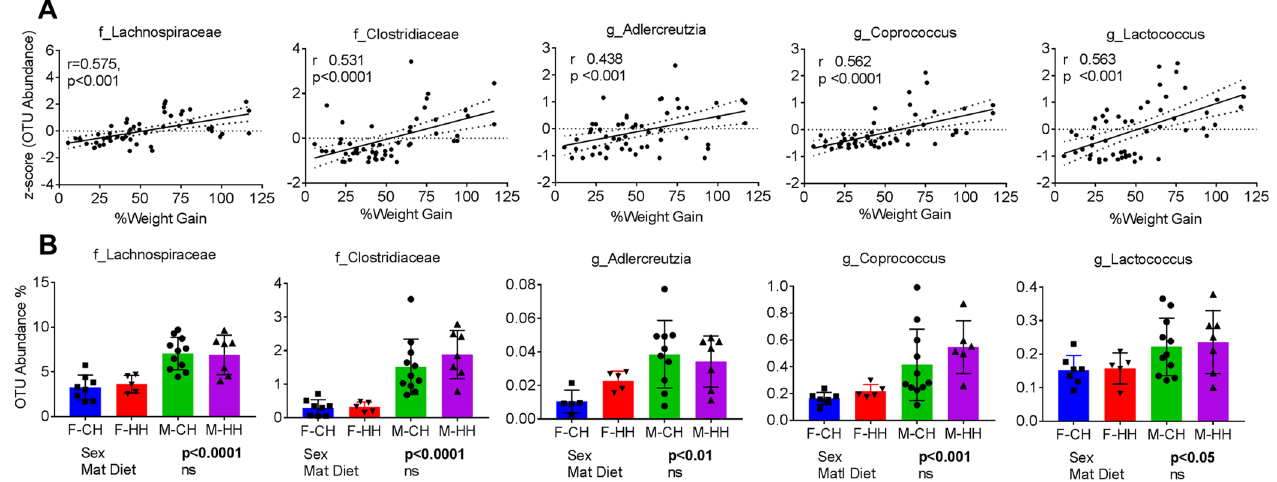
Figure 4. Bacterial taxa associated with offspring weight gain. ( A ) Pearson’s correlations of f_Lachnospiraceae, f_Clostridiaceae, g_Coprococcus, g_Adlercreutzia and f_Lactococcus with weight gain over the diet intervention period irrespective of sex of the offspring. Correlation co-efficients and p-values for linear regressions were calculated using Pearson’s correlation. ( B ) Microbial OTU abundance showing sexually dimorphic expression in male and female offspring when fed postnatal HFD. Data are expressed as means ±